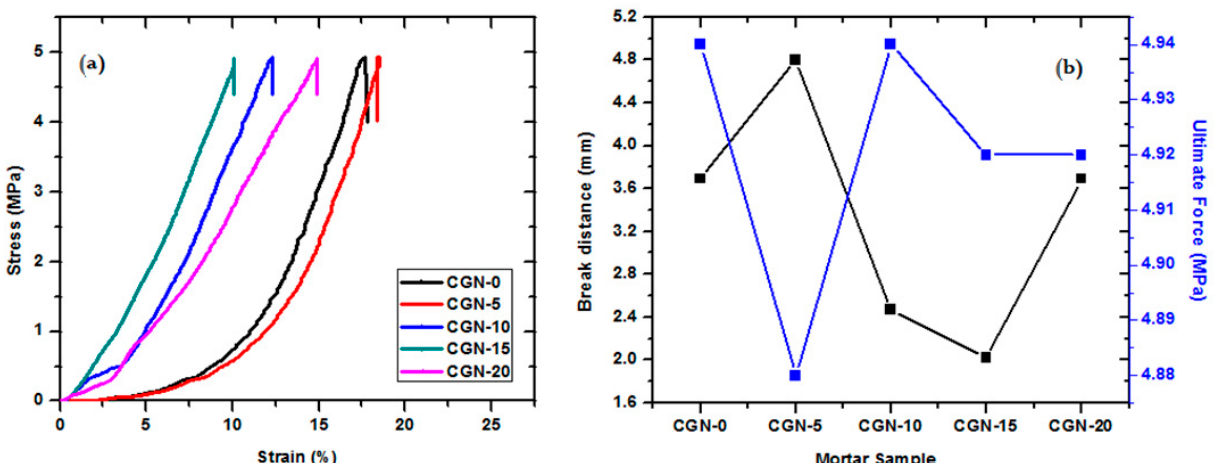
Figure 7. ( a ) The stress–strain curve, ( b ) the break distance and ultimate force of prepared samples.